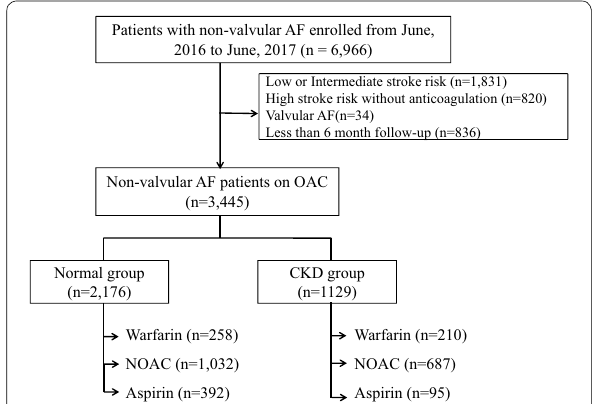
Fig. 1 Flowchart of patient enrollment. AF, atrial fibrillation; OAC, oral anticoagulant; CKD, chronic kidney disease; NOAC, non‑vitamin K antagonist oral